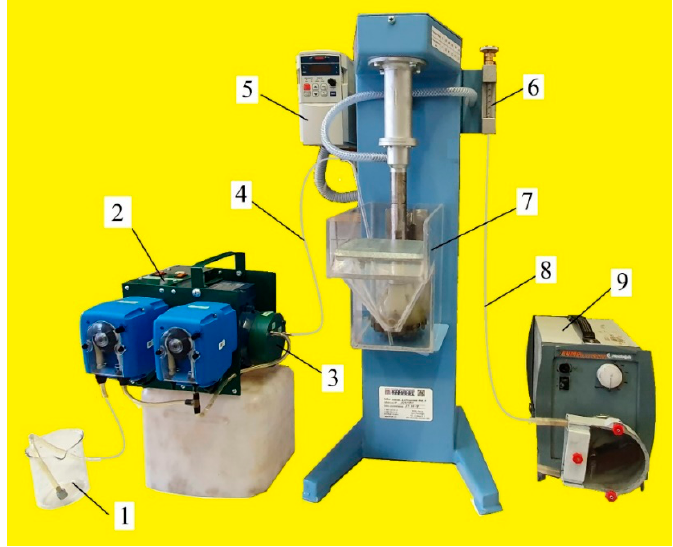
Figure 3. Laboratory rig designed for studying combined microflotation processes: ( 1 ) frother solution; ( 2 ) air-in-water microdispersion generator MBGen-0.012; ( 3 ) dispergator head; ( 4 ) pipe for supplying air-in-water microdispersion into flotation cell; ( 5 ) thyristor revolution per minute